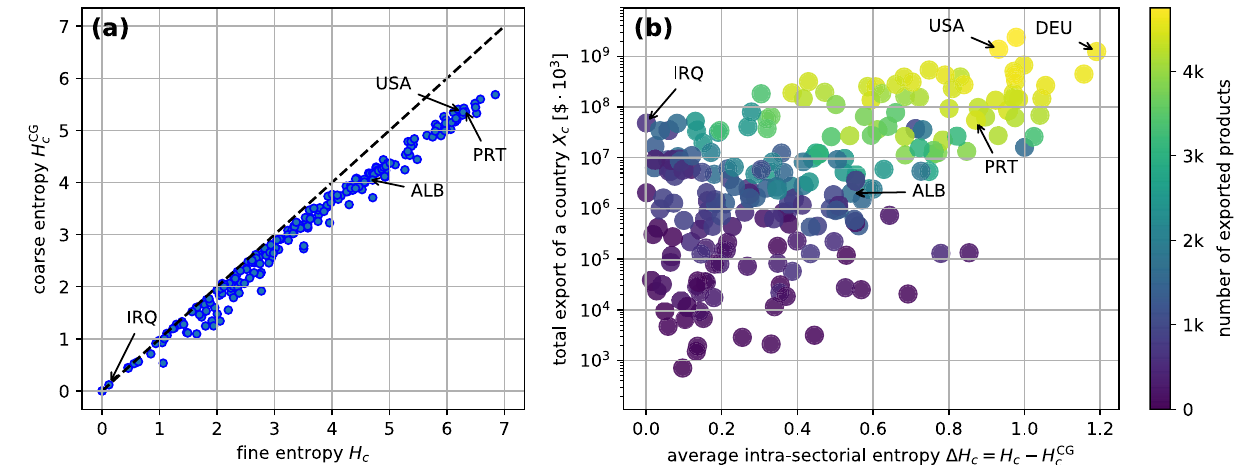
Figure 6. ( a ) Comparison between the fine-grained (6 digit HS07 classification) entropies H c of the countries CG for Eq. (10) and the coarse-grained (4 digits HS07 classification) entropies H c of Eq. (12). The quadrant CG (cid:31) H c of Eq. (14) bisector marks the inequality H c > H c relating the two. ( b ) Average intra-sectorial entropy plotted against the overall export of a country X c . Germany (DEU) emerges as the country with the highest (cid:31)